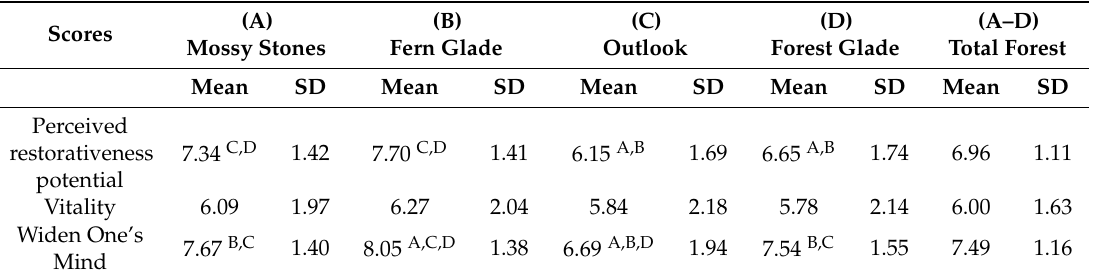
Table 1. Qualities of the places and the